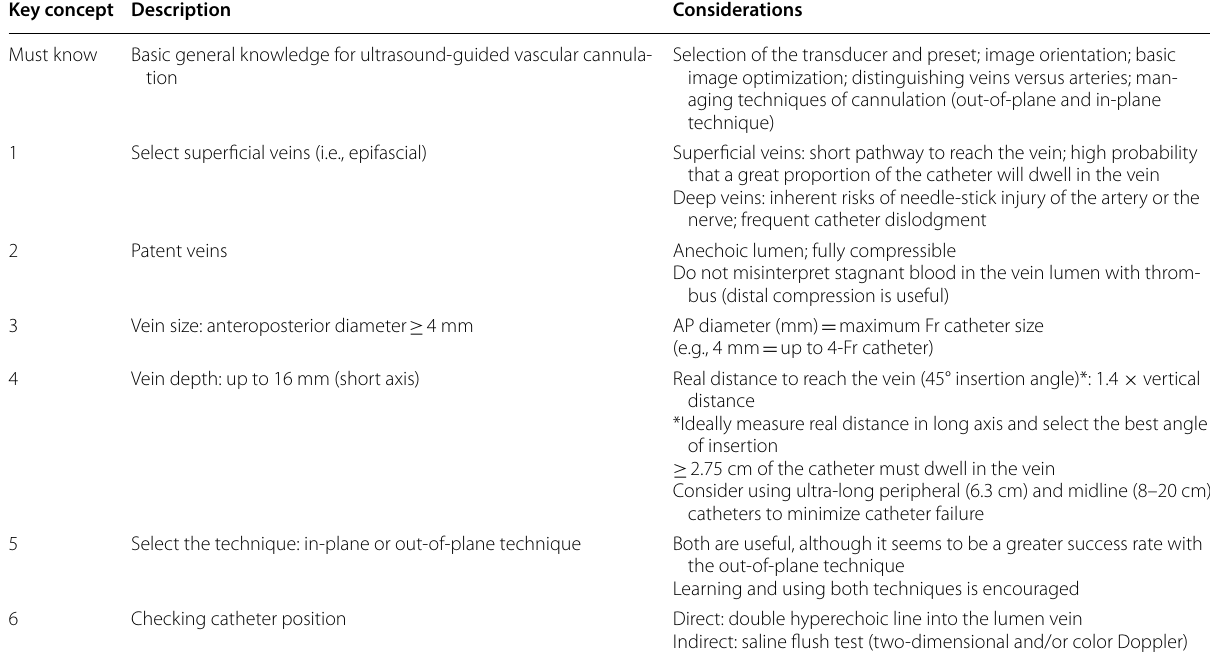
Table 1 Key concepts for ultrasound-guided peripheral venous cannulation Key concept Description